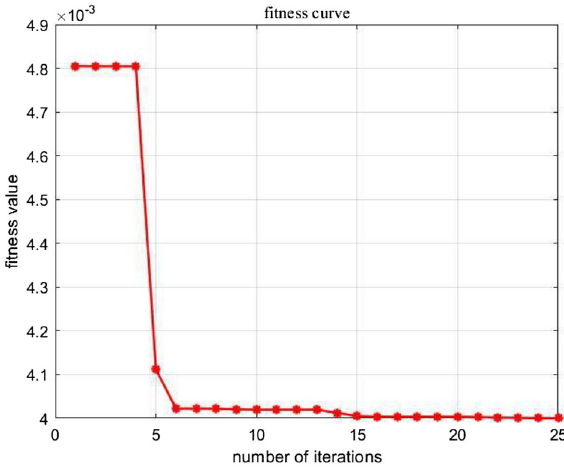
Figure 4. Fitness iteration curve.